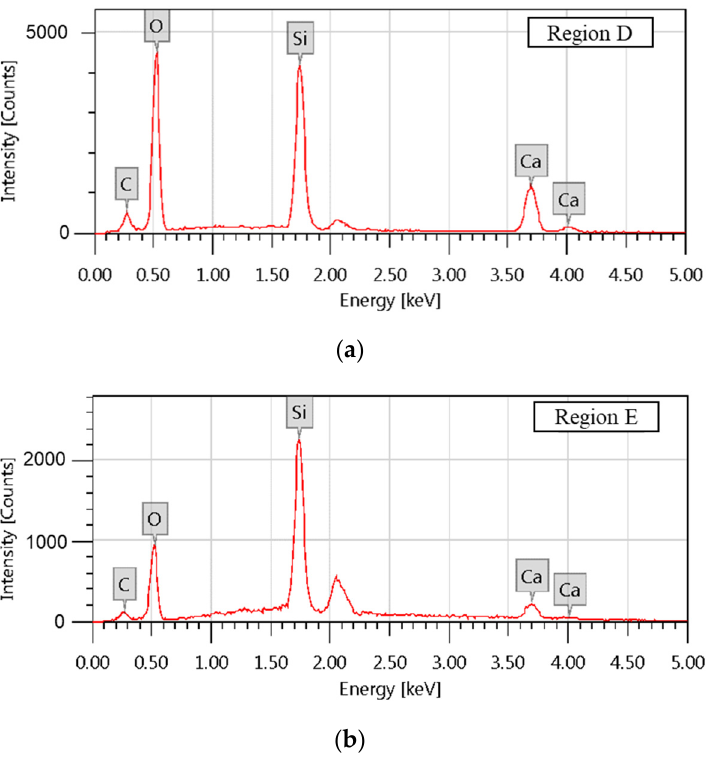
Figure 10. Microstructures of samples with an initial C/S molar ratio of 1.0.